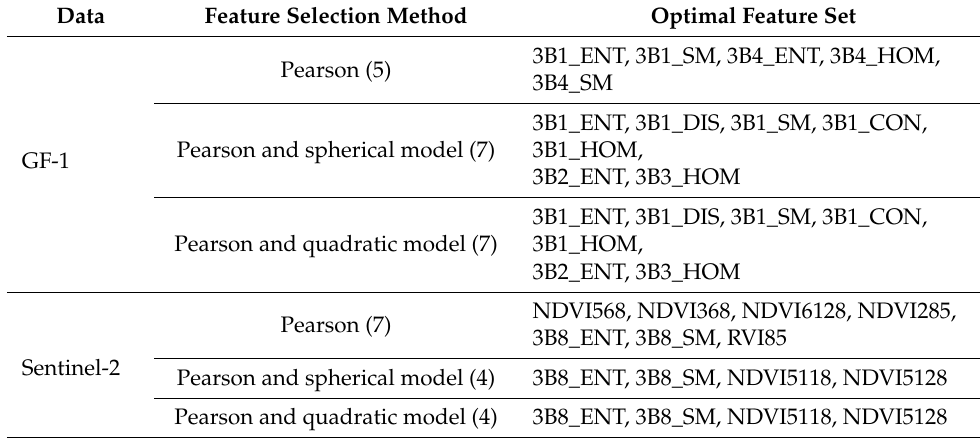
Table 6. Optimal feature set according to various feature selection